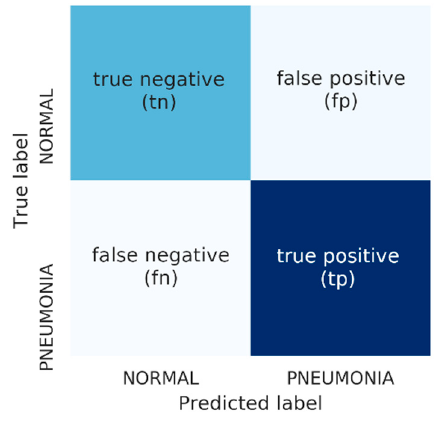
Figure 5. Confusion matrix convention.